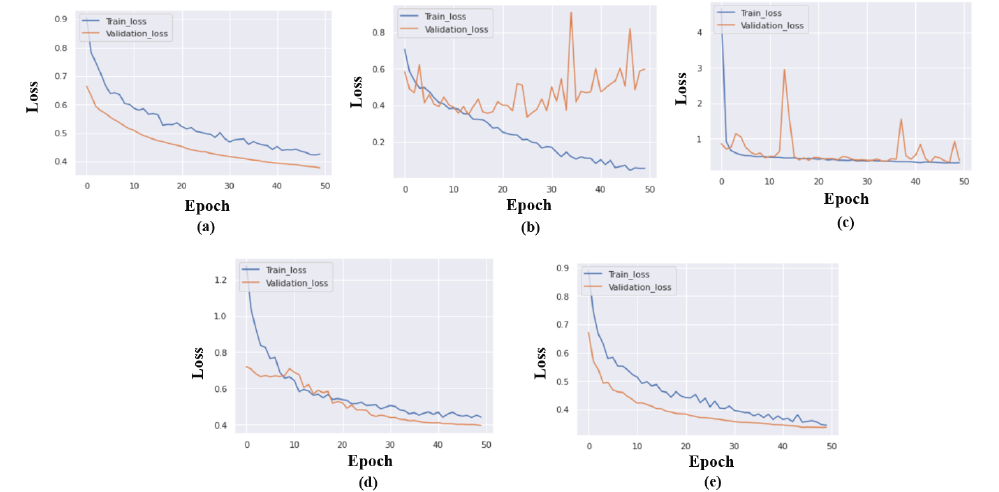
Figure 6. Plots of model loss of ( a ) Xception, ( b ) VGG19, ( c ) EfficientNetB0, ( d ) MobileNetV2, and ( e ) Resnet50V2 following each epoch applied to both the training and validation